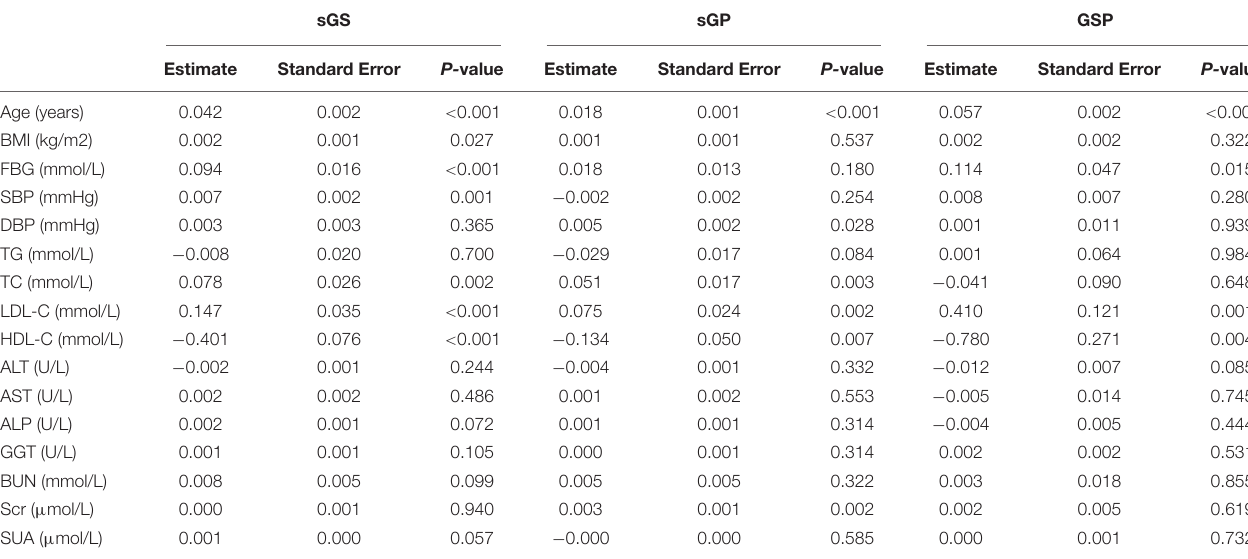
TABLE 3 | Multivariate analysis of risk factors of gallbladder stones and gallbladder